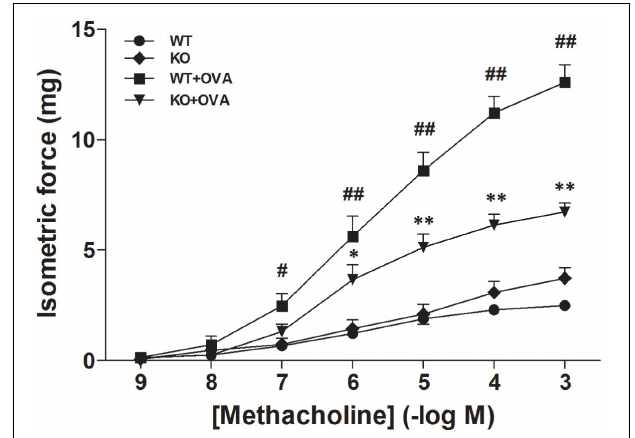
FIGURE 1 | Gene deletion of KCa3.1 reduced established OVA-induced changes in constrictor responsiveness to methacholine in mouse bronchi. Relative to WT group bronchi, maximal isometric contractile force responses to methacholine were significantly increased in WT + OVA group bronchi, and this increased constrictor responsiveness to methacholine was prevented in KO + OVA group bronchi tissues. Data represented means ± SEM ( n = 4–6). # p < 0.05, ## p < 0.01 versus WT mice. ∗ p < 0.05, ∗∗ p < 0.01, two-way ANOVA followed by the Bonferroni multiple comparison test compared with WT + OVA group mice. WT, wildtype; KO,